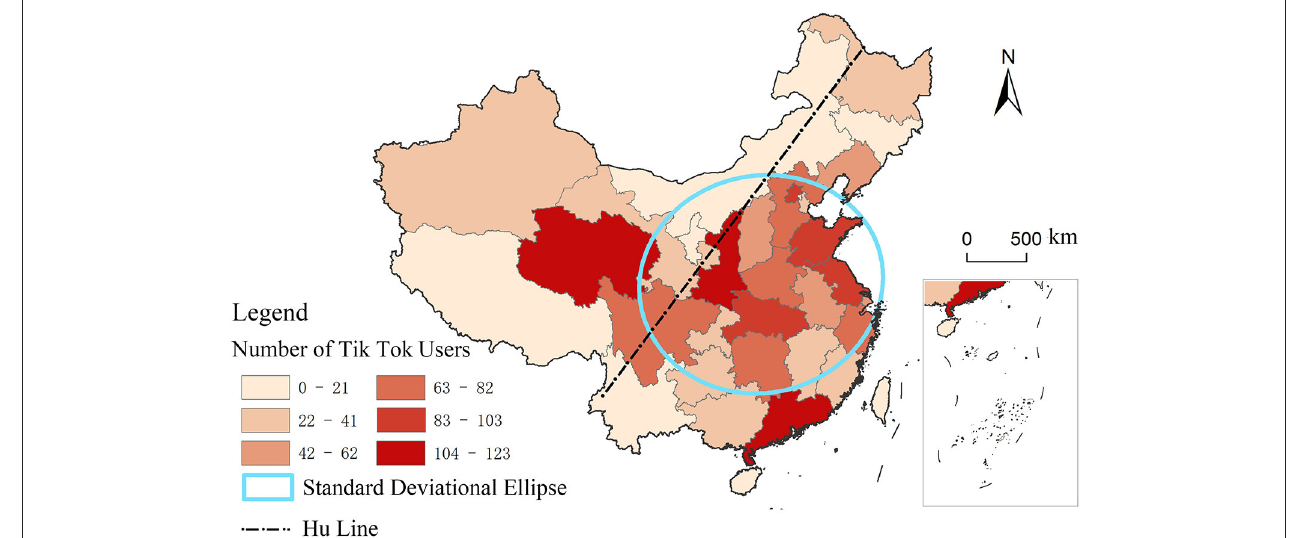
FIGURE 8 | Provincial spatial distribution and direction distribution of short-video disseminators.